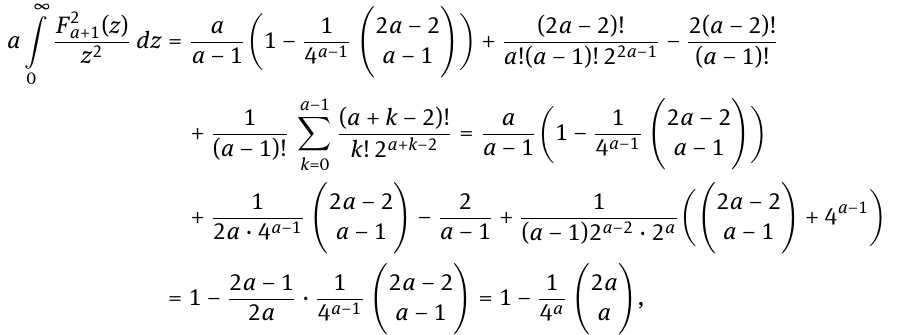
Figure 8: Symmetric Gamma copula density c Γ